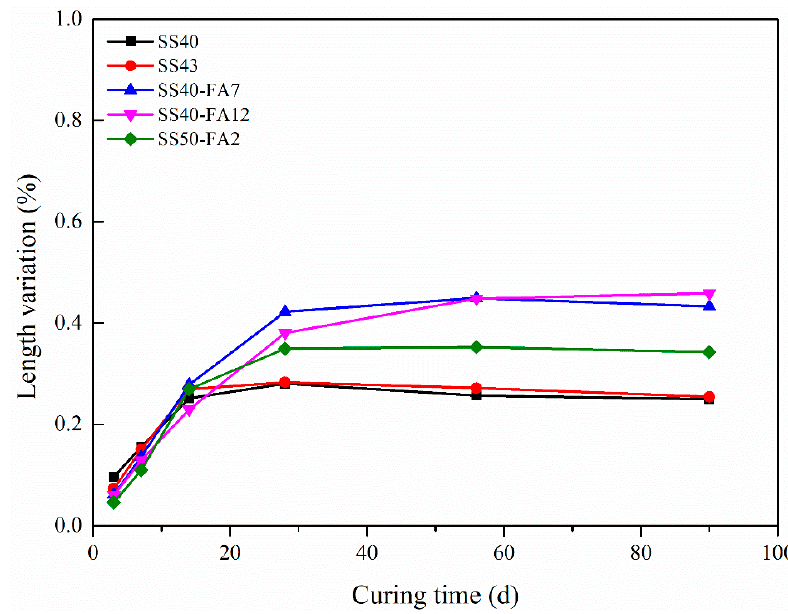
Figure 8. The linear expansion ratio of SS-based composite cementitious materials under water curing up to 90 days.